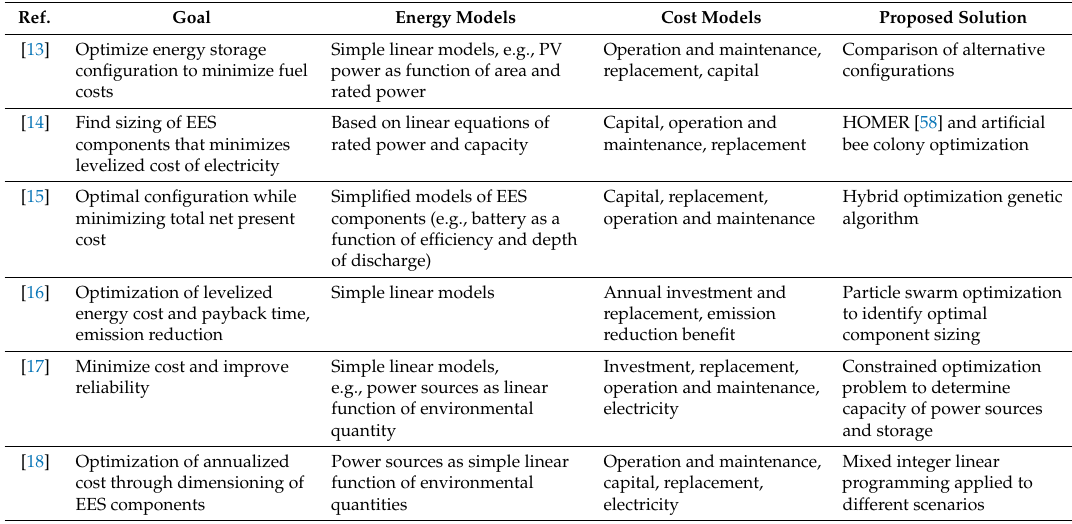
Table A1. Overview of recent representative related works on cost estimation of EES Systems.